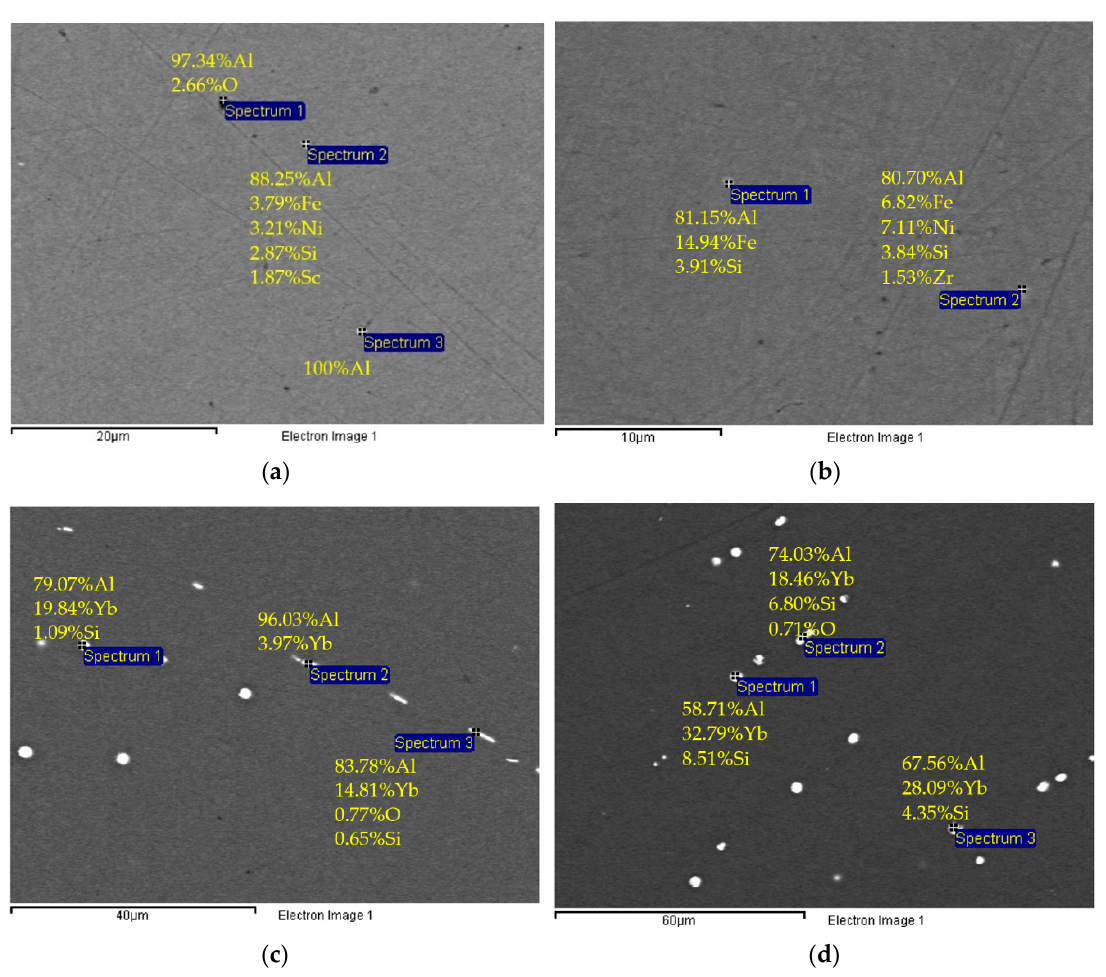
Figure 1. EDS analysis (wt.%) of particles in UFG alloy specimen Nos. 2 ( a ), 3 ( b ), 4 ( c ), and 6 ( d ). SEM.